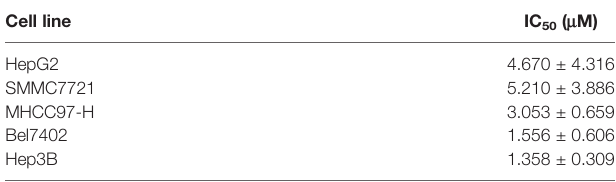
TABLE 1 | The antiproliferative activity of CK-3 on HCC cell lines (mean ± SD, n=3). Cell line